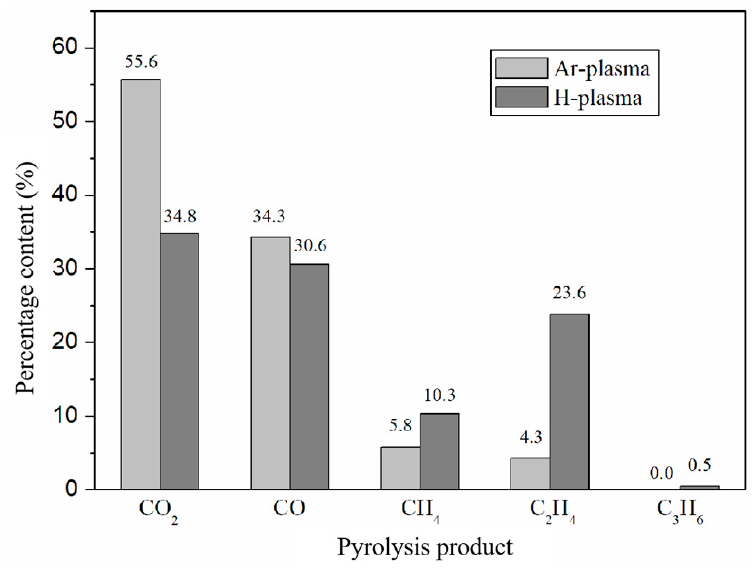
Figure 5. Columnar comparison of the pyrolysis product content of Ar-plasma and Ar/H 2 -plasma.